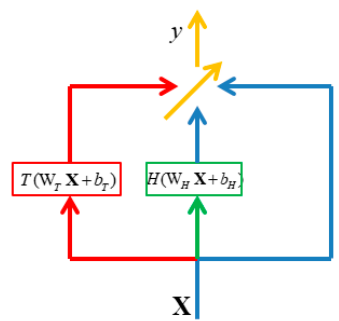
Figure 2. Illustration of highway networks.